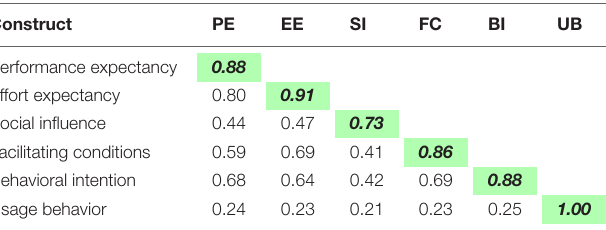
TABLE 2 | Discriminant